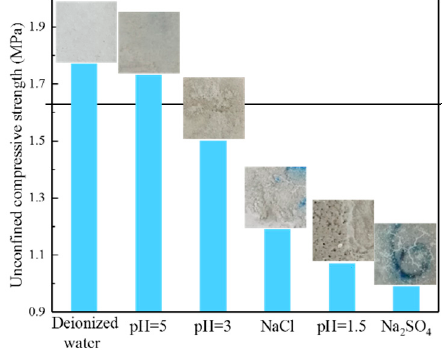
Figure 8. Visual inspection of the PG-based backfill specimens with di ff erent exposure solutions after 30 drying-wetting cycles.